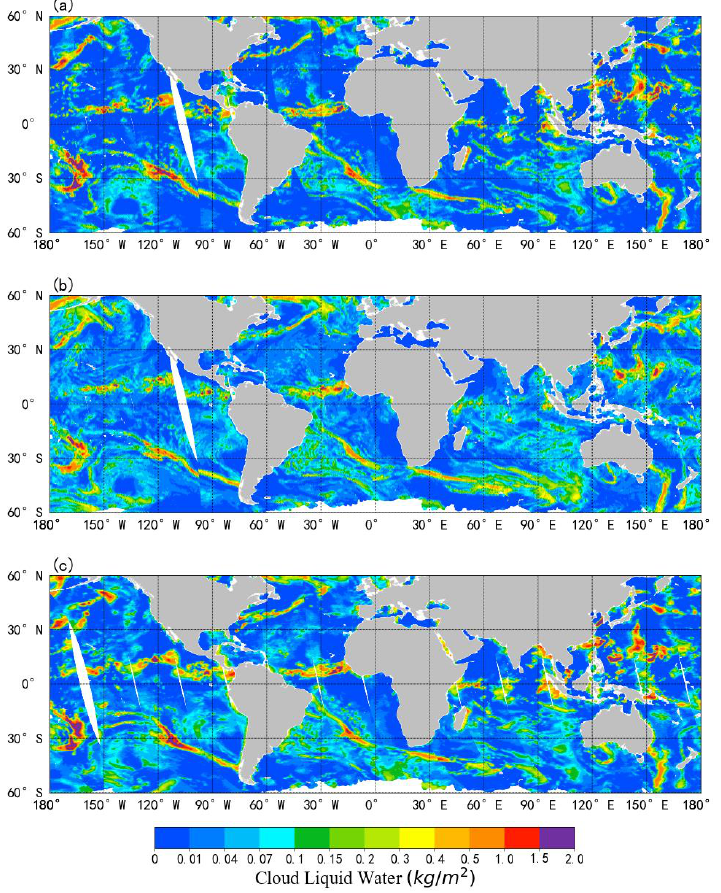
Figure 12. CLW retrieved from MWTS-III and ATMS over global oceans on 1 August 2021. ( a , c ) The cloud liquid water path retrieved from of MWTS-III and ATMS using the physical algorithm; ( b ) CLW from ERA5 reanalysis at the time of MWTS-III.